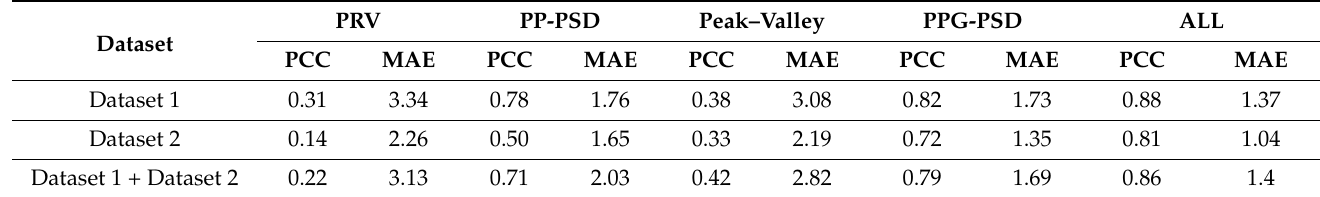
Table 3. Average mean absolute error (MAE), interpretable in breaths per minute, and Pearson’s correlation coefficient (PCC) achieved with the proposed ML-method trained with different feature sets, using a window size of 20 s. The results are achieved using leave-one-subject-out (LOSO) cross-validation, on three dataset